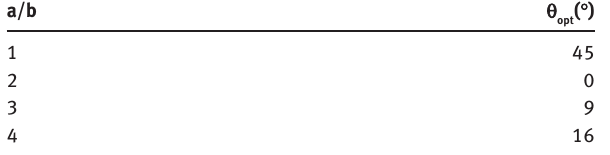
Table 4 Effect of boundary conditions on the optimum results for laminated square spherical